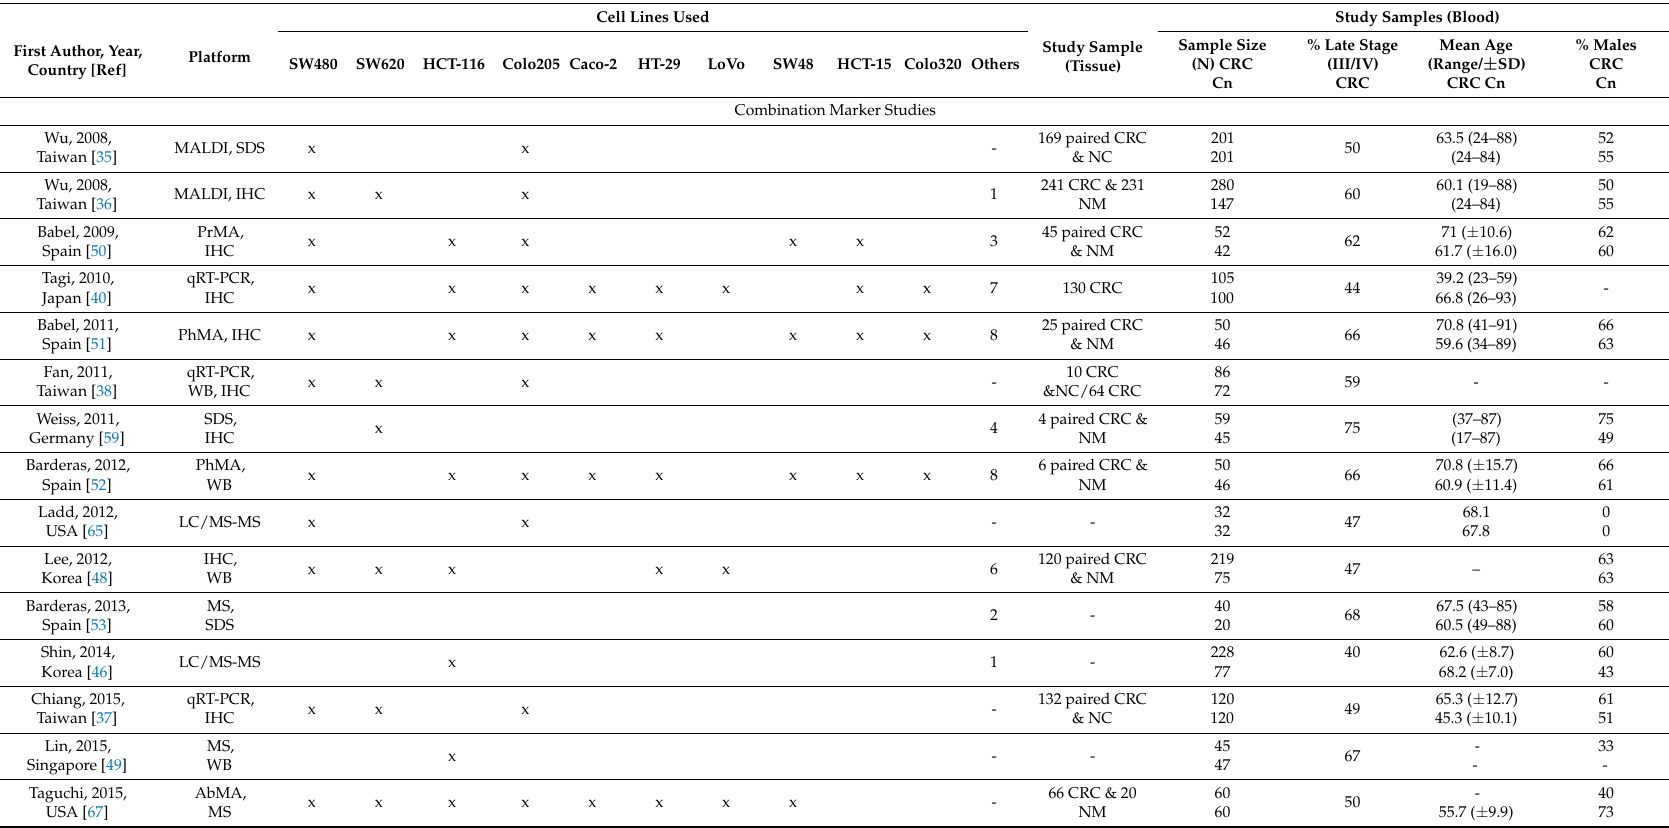
Table 1. Study characteristics of the cell line secretome